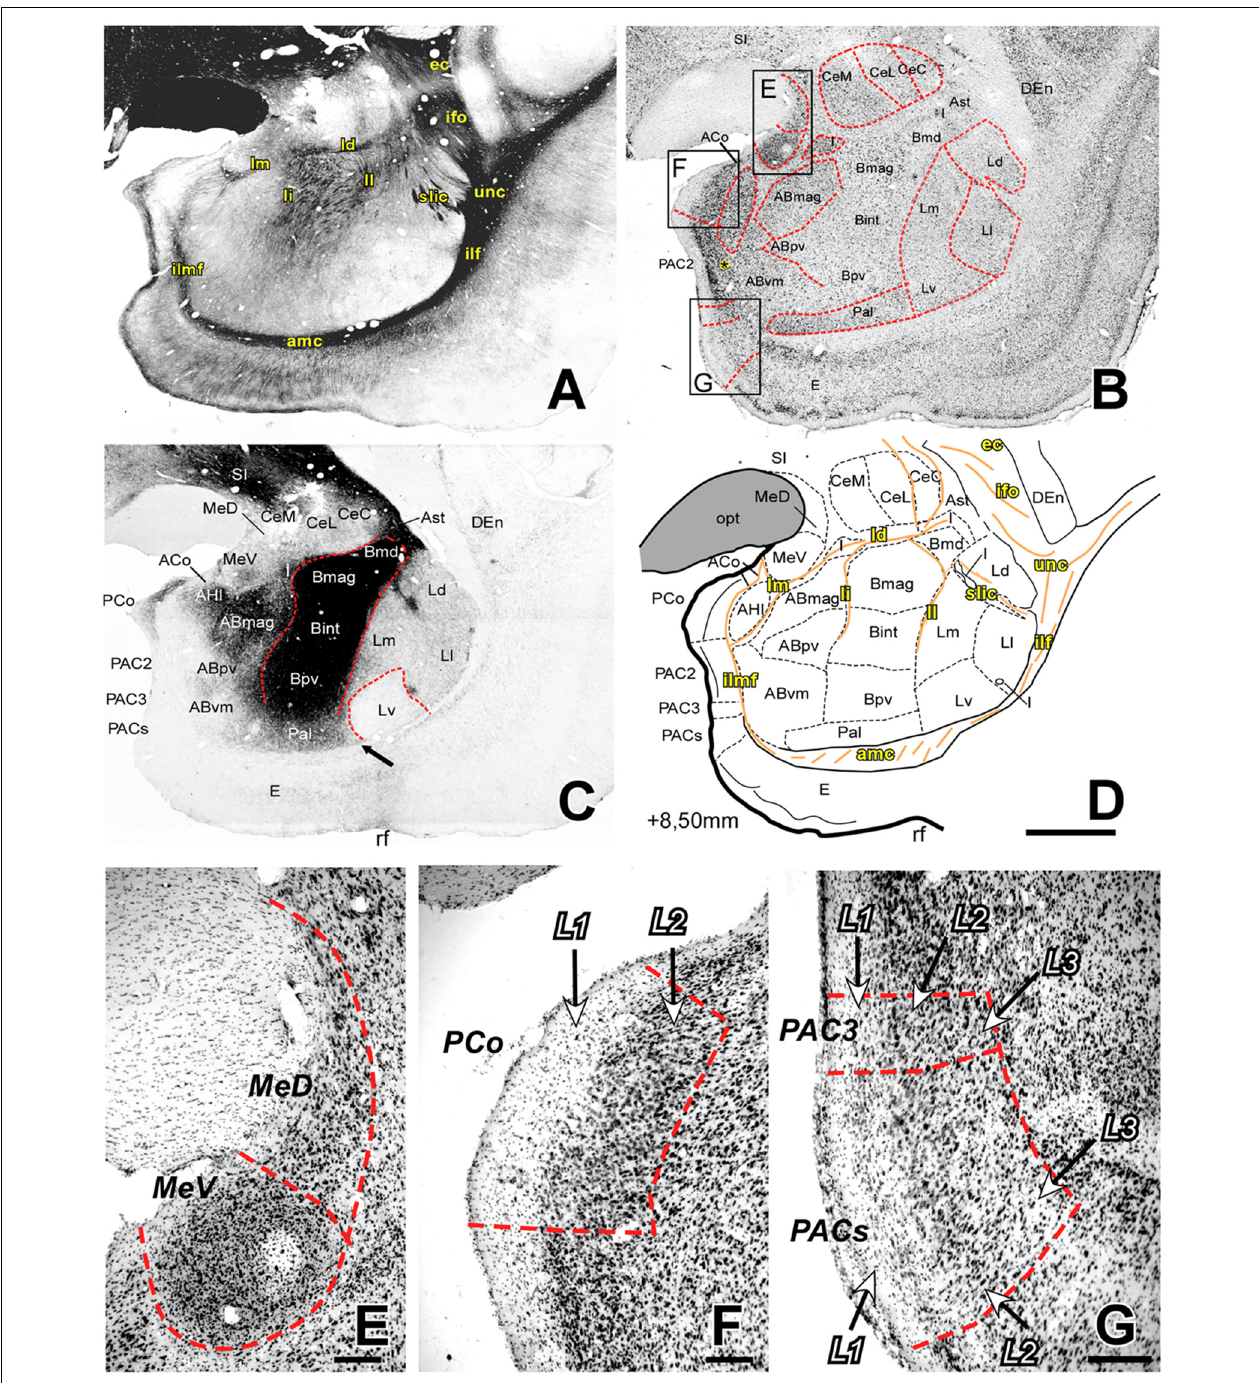
FIGURE 3 | Myelo- and cytoarchitecture, level 3 (Interaural 8.50 mm). Series of adjacent coronal sections stained for Gallyas (A) , Nissl (B) and AChE (C) and the corresponding drawing showing in black the territories of the AC and in orange the myelinic bundles schematically (D) . Unambiguous nuclear boundaries are drawn with a red dashed line. The divisions of the Ce showed no difference in AChE at this level (C) . The presence of heavily AChE stained I within the L, separating its subdivisions (C,D) is also distinctive in this level. Myelin fibers clearly demarcate the ventral border of the Ce and are very abundant in the B (A) . Panels (E–G) are high magnification bright-field photomicrographs from Nissl-stained sections in different portions of the superficial areas of the AC (corresponding to the black squares in B ); the layers are indicated in each region. In (E) , the most caudal level of the Me, the MeV has lost the layered pattern and contains highly compacted cells; (F) posterior cortical nucleus (PCo) is characterized by only two layers. (G) Two of the three PAC subdivisions present at this level are shown: PAC 3 (superior) and PACs (inferior), both containing lightly stained neurons in L1. Scale: 1 mm in (A–D) and 200 µ m in (E–G) . The asterisk in panel B is located in L3 of PAC2, which contains more scattered Nissl-stained cells than